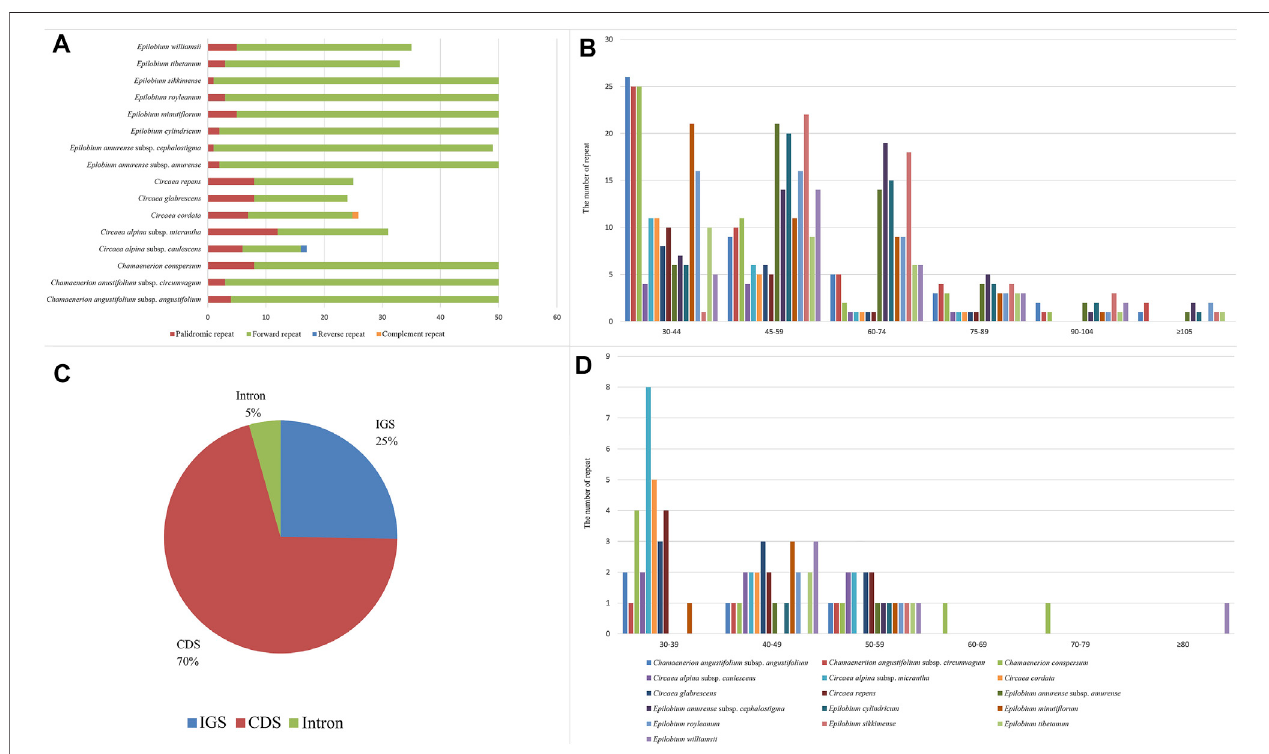
FIGURE5| Analysesofrepeatedsequencesin16newlysequencedchloroplastgenomesofOnagraceae. (A) :numberoffourrepeattypes; (B) :frequencyofdirect repeats by length; (C) : location of repeats; (D) : frequency of palindromic repeats by length.